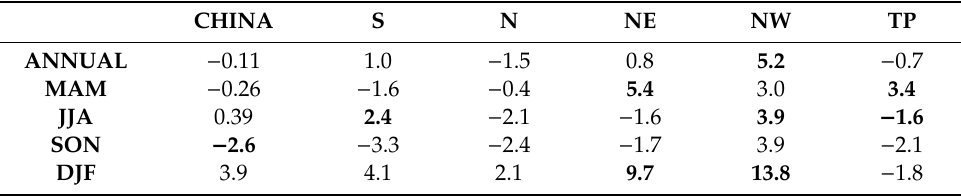
Table 1. Temporal trends of annually and seasonally averaged precipitation amount for the station observations (bold values indicate that they pass the significance test with a 95% confidence level) (unit: %/10 years).